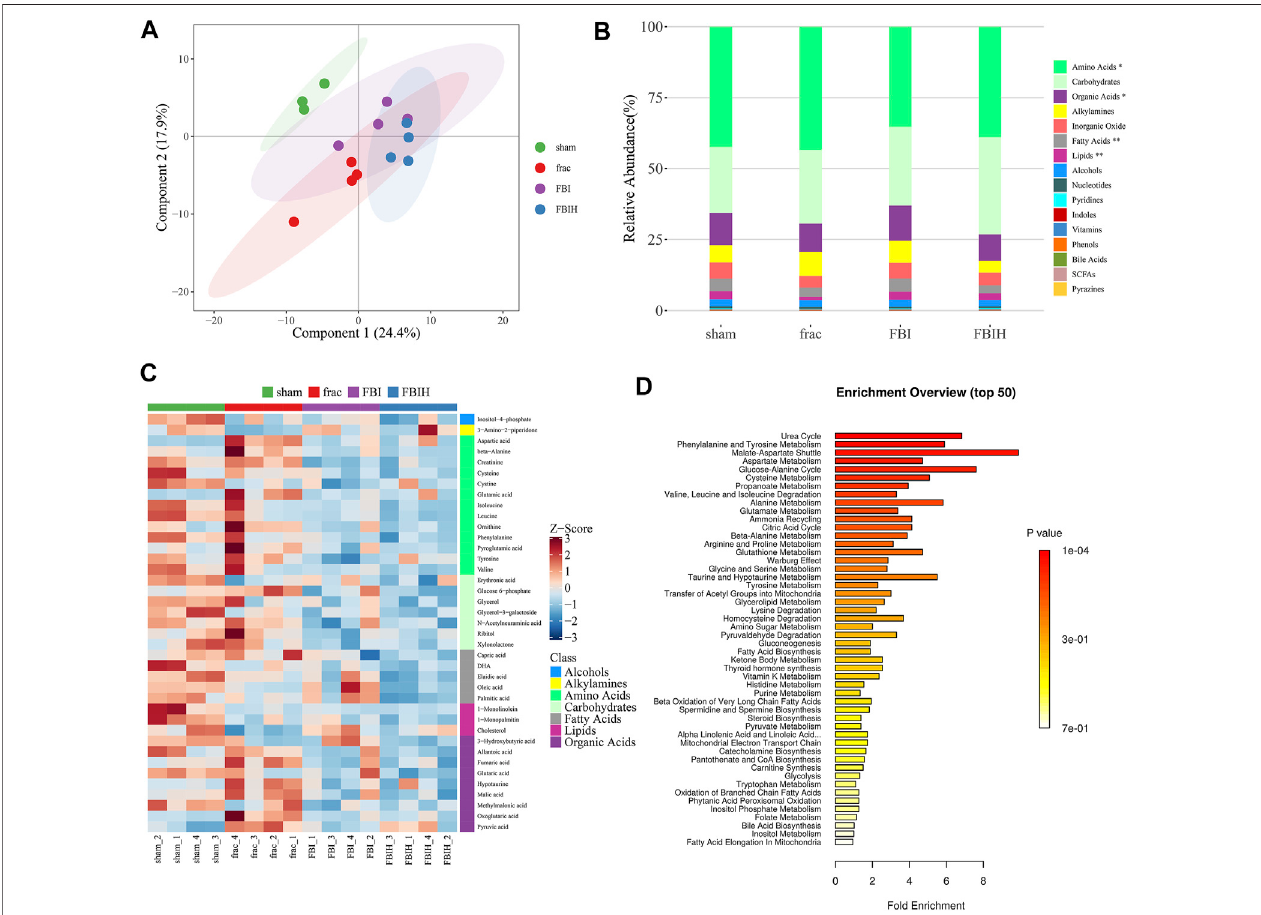
FIGURE 8 | Aberrant metabolic patterns in serum samples in different groups. (A) PLS-DA score plot of serum samples urine samples discrimination of the metabolome between four groups, the control vs. Fracture-only vs. Fracture + TBI vs HPASD (9.6 g/kg) treated group. (B) Taxonomic distributions of metabolite in the different groups (C) Heatmap visualization of the differential metabolites identi fi ed in the serum samples from the different groups (D) Metabolic pathway analysis of the differential metabolites of the serum samples from the different groups.